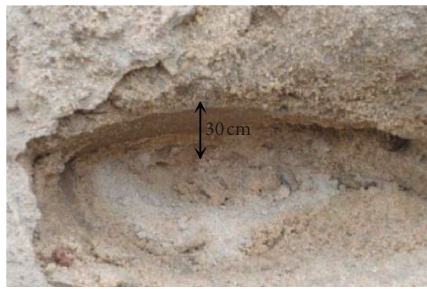
Figure 9: The depth of permeation. Table 2: Strength of sampling at slope test points.